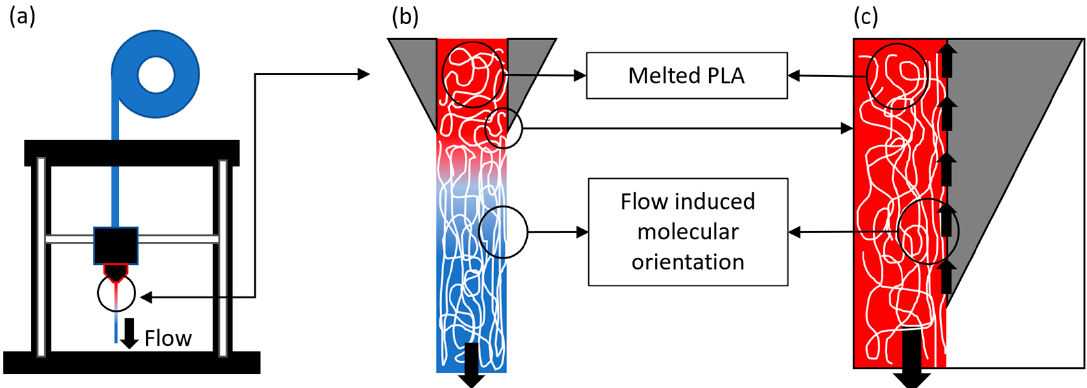
Figure 8. Flow-induced molecular orientation: ( a ) printing process, ( b ) detail of the nozzle and printed PLA, ( c ) detail of the shear forces between the nozzle and the PLA.